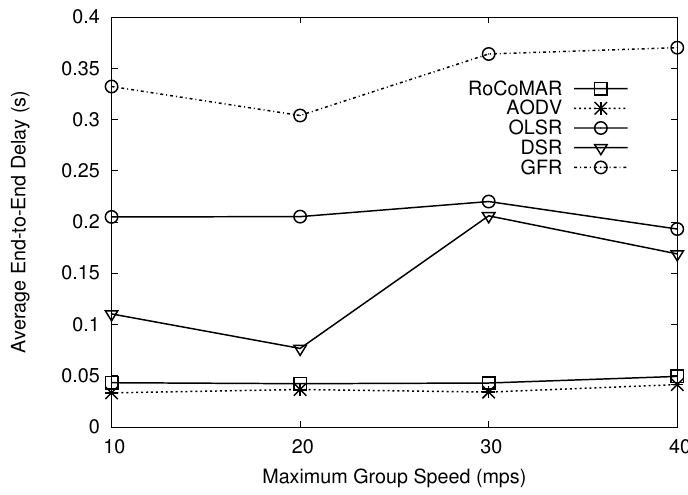
Figure 8. Effects of node mobility on average end-to-end